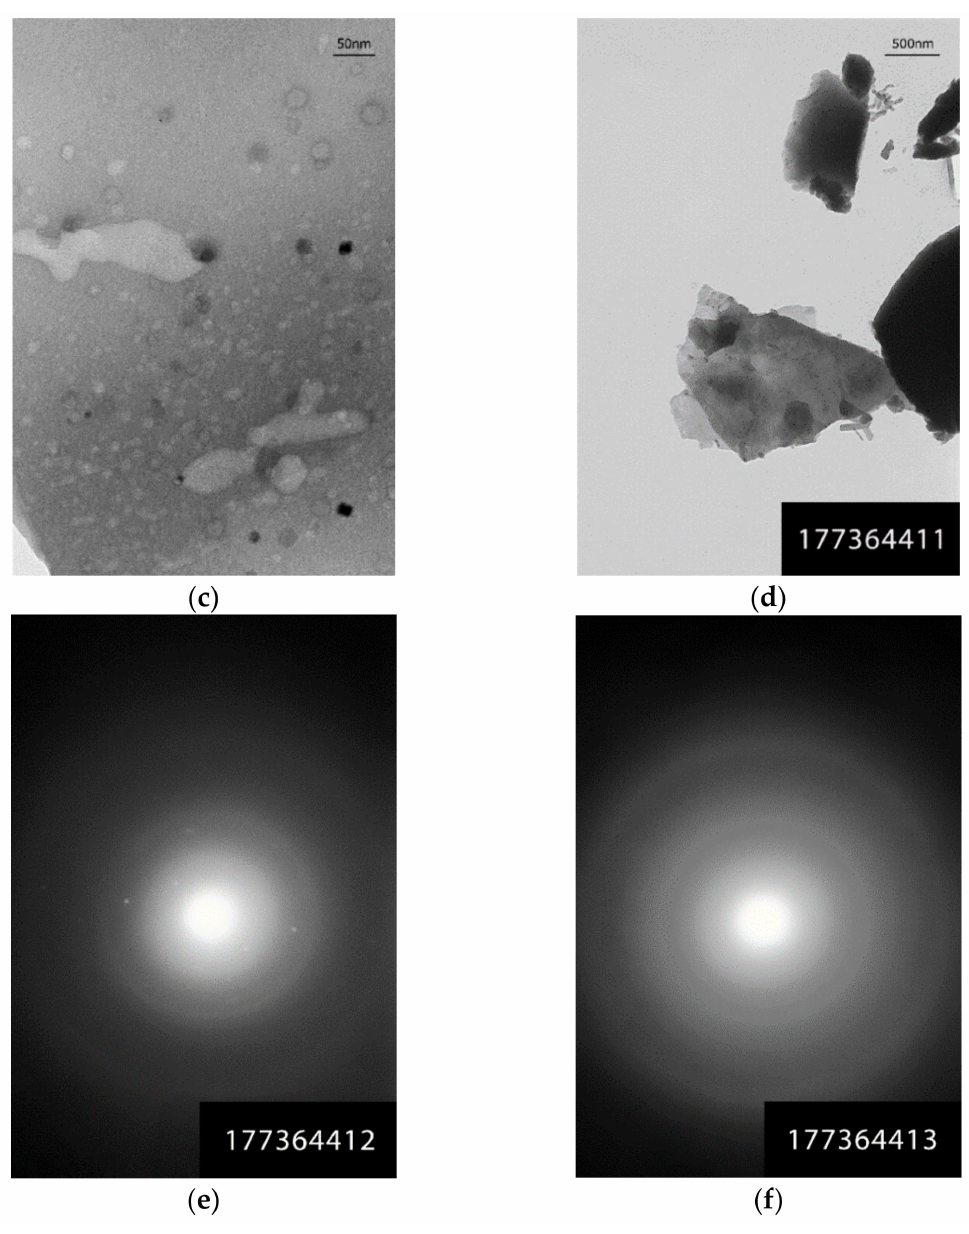
Figure 8. TEM micrographs and microdiffraction patterns of carbonized rise husk: ( a ) rice husk particles carbonized at 650 ◦ C; ( b ) rice husk particles aggregates carbonized at 1000 ◦ C; ( c ) porous hybrid formation obtained by rice husk carbonization at 600 ◦ C; ( d ) cluster of differently shaped particles of rice husk carbonized at 650 ◦ C; ( e ) microdiffraction patterns from the particles shown in Figure 8a; ( f ) microdiffraction patterns from the particles shown in Figure